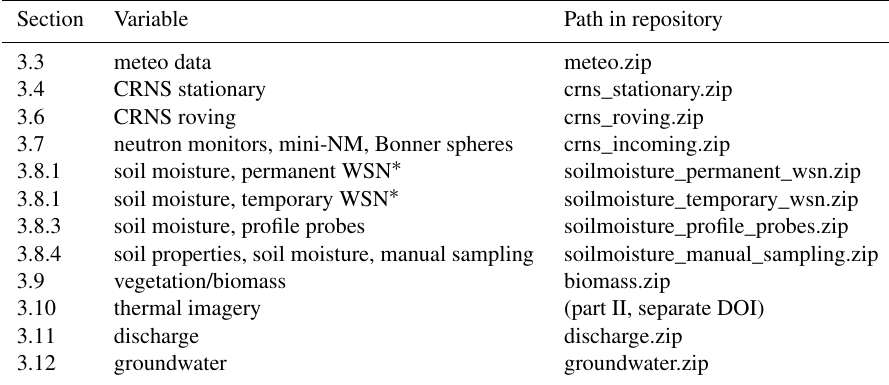
Table 3. Overview of data categories and their path in the